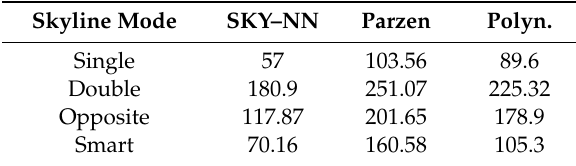
Table 5. Total time needed to perform a classification task on the real dataset.